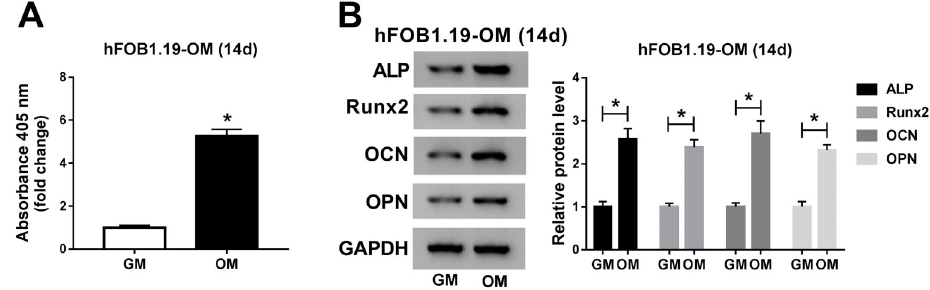
Figure 3. ALP activity and marker expression were increased during osteogenesis. A , The activity of ALP was determined in hFOB1.19 cells cultured with growth medium (GM) or osteogenic medium (OM) (14d). B , The expression of osteogenic differentiation markers was determined by western blot assay. Data are reported as means ± SD of three independent experiments. *P o 0.05 ( t -test).